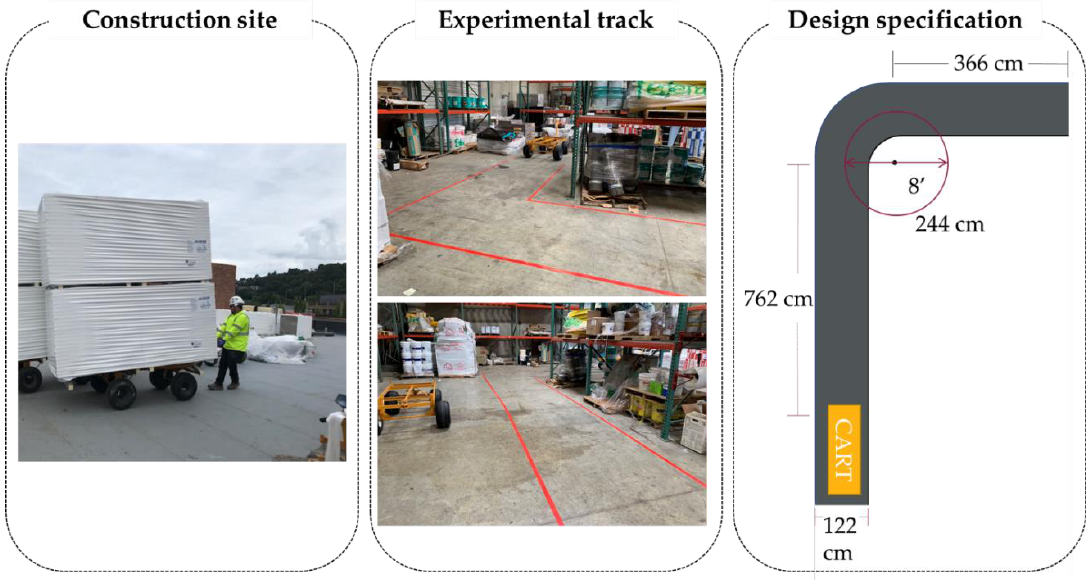
Figure 2. L-shaped track